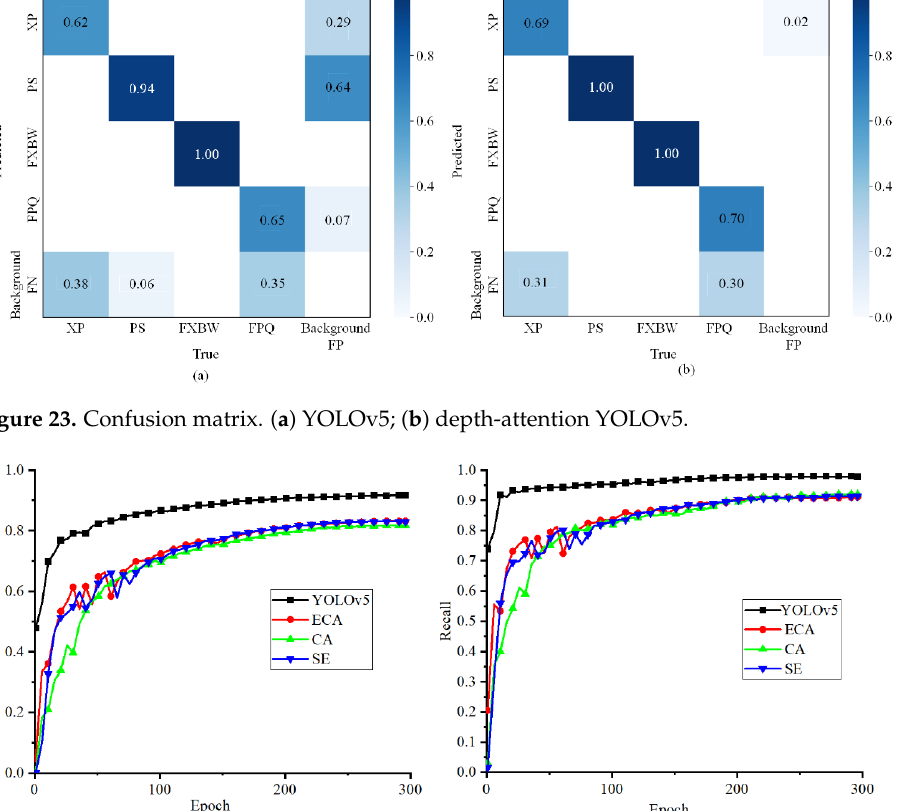
Figure 23. Confusion matrix. ( a ) YOLOv5; ( b ) depth-attention YOLOv5.